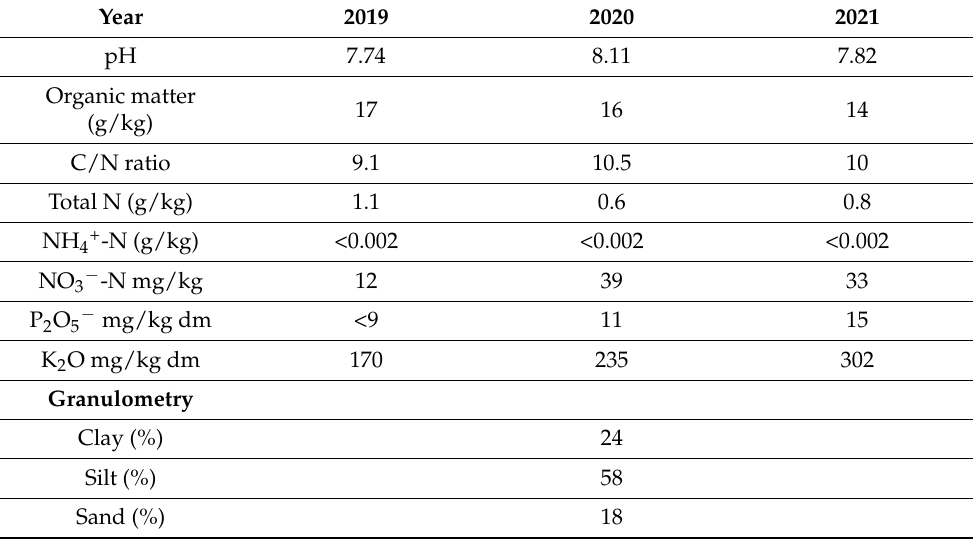
Table 2. Physical and chemical soil characteristics at the VM experimental